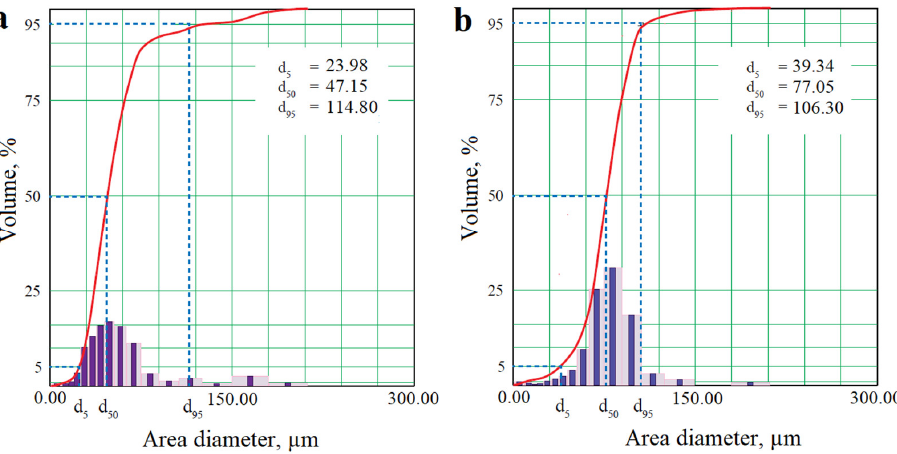
Figure 1. Integral curves and histograms of particle size distribution of powders: ( a ) PM-M; ( b ) PMS-M99.9.